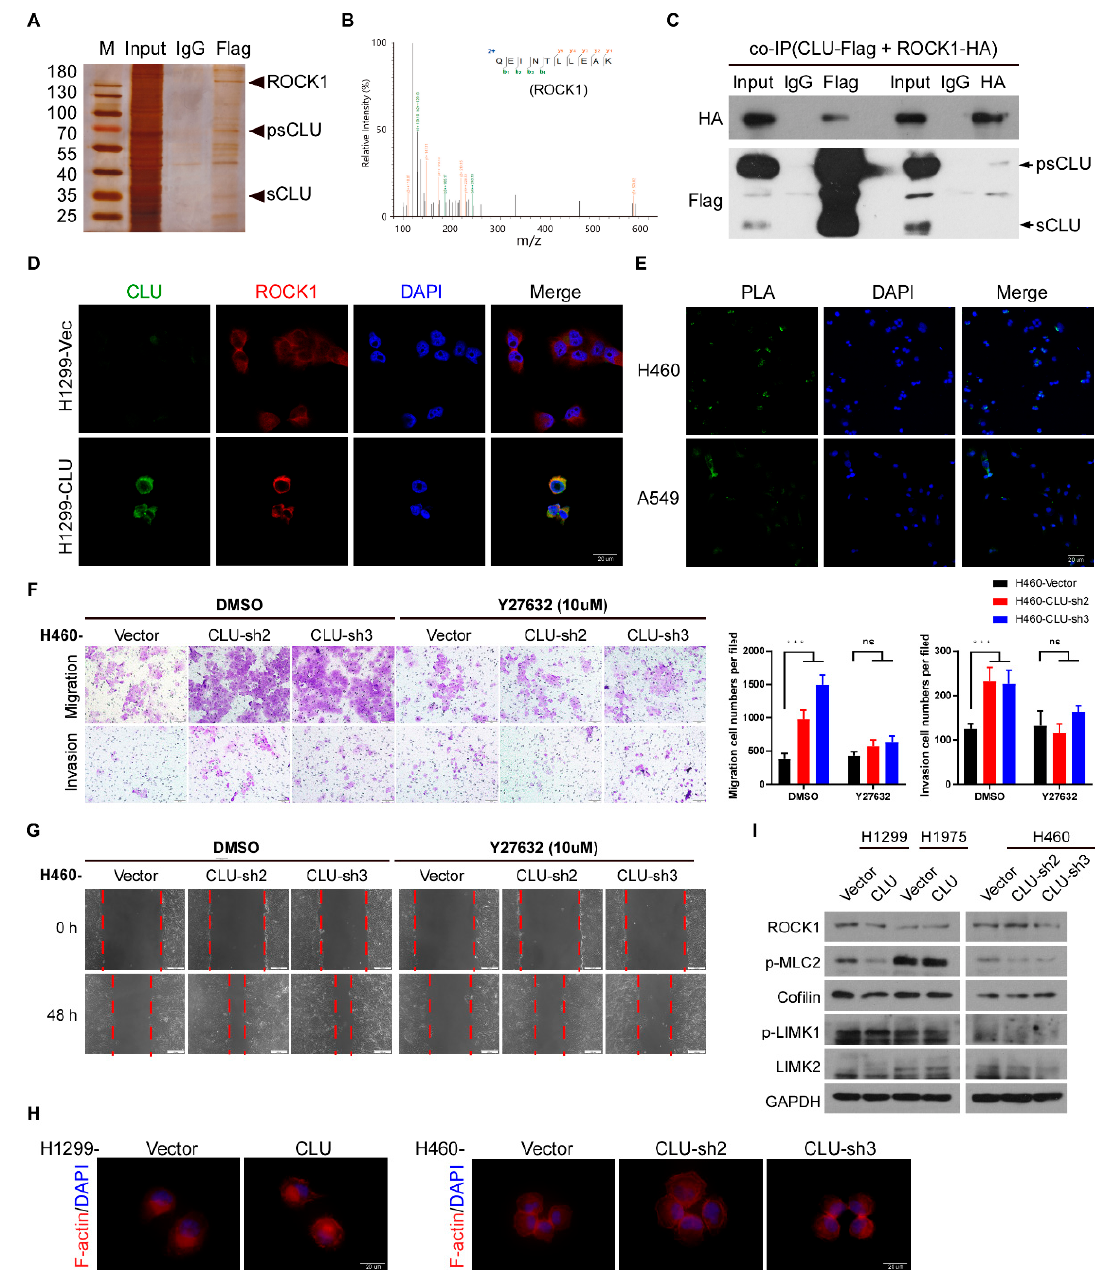
Figure 4. CLU interacts with ROCK1 to suppress metastatic traits. ( A , B ) IP–MS analysis was per- formed using 293FT cells with ectopic expression of CLU-Flag. Metastasis-related regulator ROCK1 was identified as a CLU binding protein. ( C ) Co-IP assay was performed in 293FT cells to confirm the interaction between precursor CLU and ROCK1. ( D ) Representative images of immunofluores- cent co-staining of intracellular CLU and ROCK1 in CLU-overexpressing and vector-control cells. ( E ) PLA assay was performed to confirm the interaction of CLU and ROCK1 in H460 and A549 cells. ( F , G ) The effect of Y27632 treatment in CLU-silenced H460 cells and vector-control cells on their